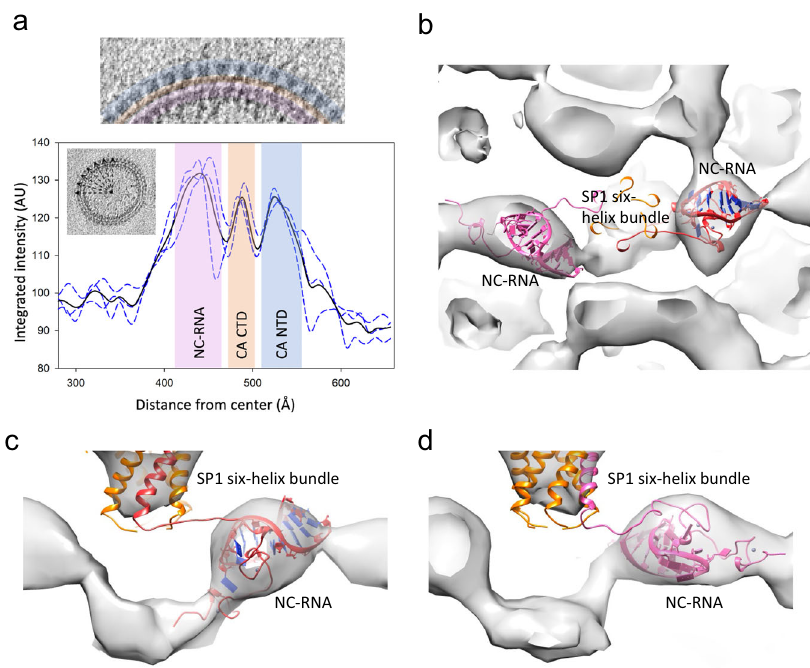
Fig. 4 Characterization of the NC-RNA density layer. a Radial density pro fi le of the Gag lattice. Top panel shows a tomographic slice of Gag Δ MA T8I lattice domain organization where CA NTD , CA CTD and NC-RNA density layers are coloured in blue, orange and pink, respectively. Graph shows the radial density pro fi les of Gag Δ MA T8I particles of similar size ( n = 3). Black line indicates the average intensity while blue lines depict the individual particle pro fi les. Density pro fi le peaks corresponding to CA NTD , CA CTD and NC-RNA are shaded with the same colour scheme as in the top panel. ( b ) Top view from density map of six-helix bundle and the NC-RNA layer, overlaid with two plausible NC-RNA ( ѱ SL2 loop) models, in red and pink, fi tted into the density, leaving the remaining NC-RNA density unmodeled. c , d Enlarged side view from density map in ( b